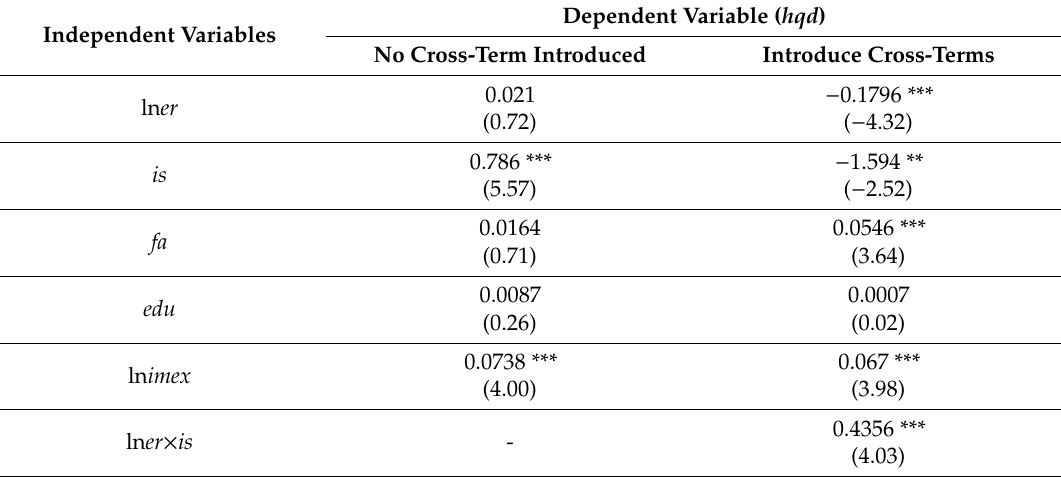
Table 5. Estimated results for the e ff ect of environmental regulation on the quality of economic development (full sample robustness